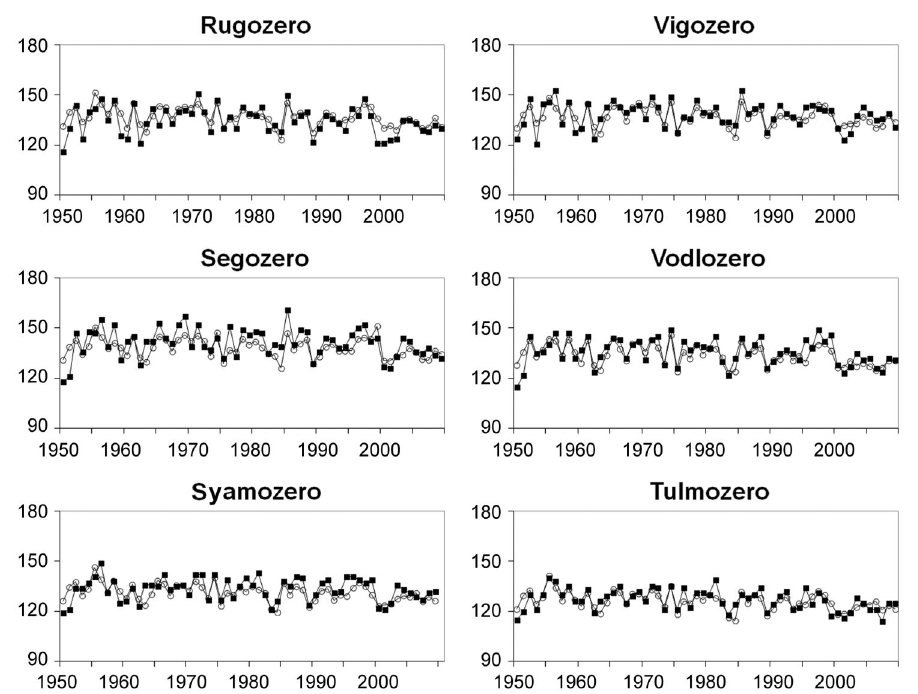
Fig. 7. Observed (line with black squares) and modelled (line with white circles) dates of ice break-up of the studied lakes in